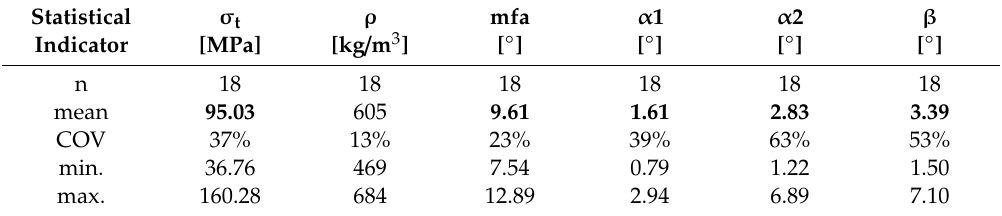
Table 1. Overview of the determined material properties of n = 18 samples. The di ff erent angles (mfa, α 1 and α 2) are furthermore an average of seven measuring points within the